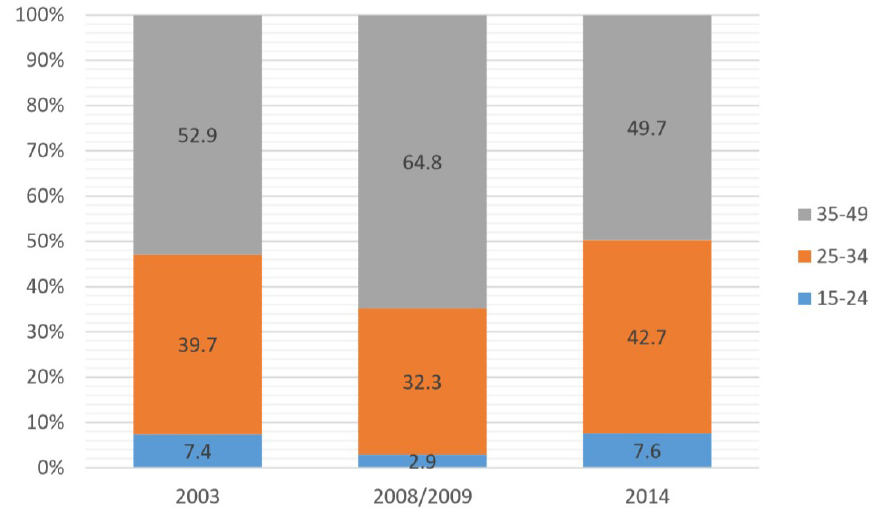
Figure 2. Intrauterine device use by age,